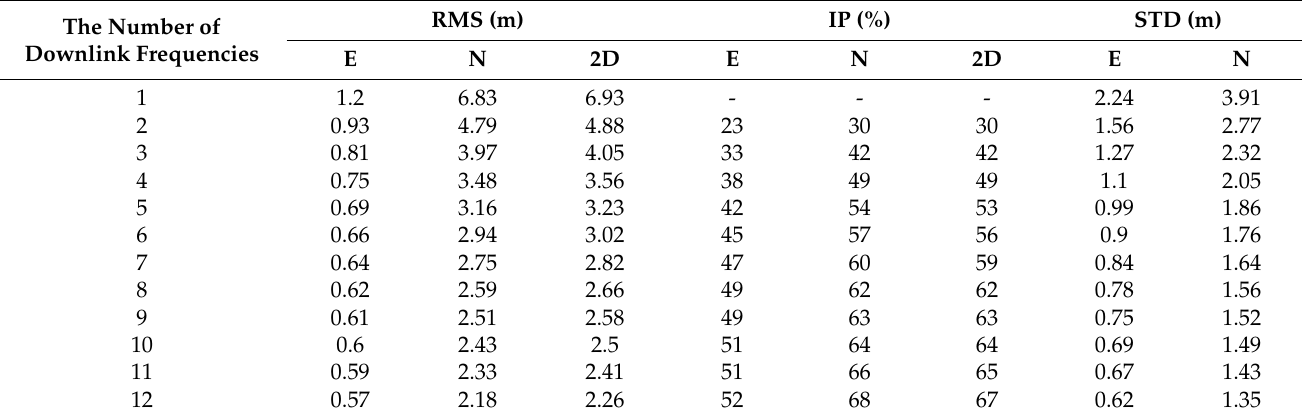
Table 3. Statistical results of the CAPS system.